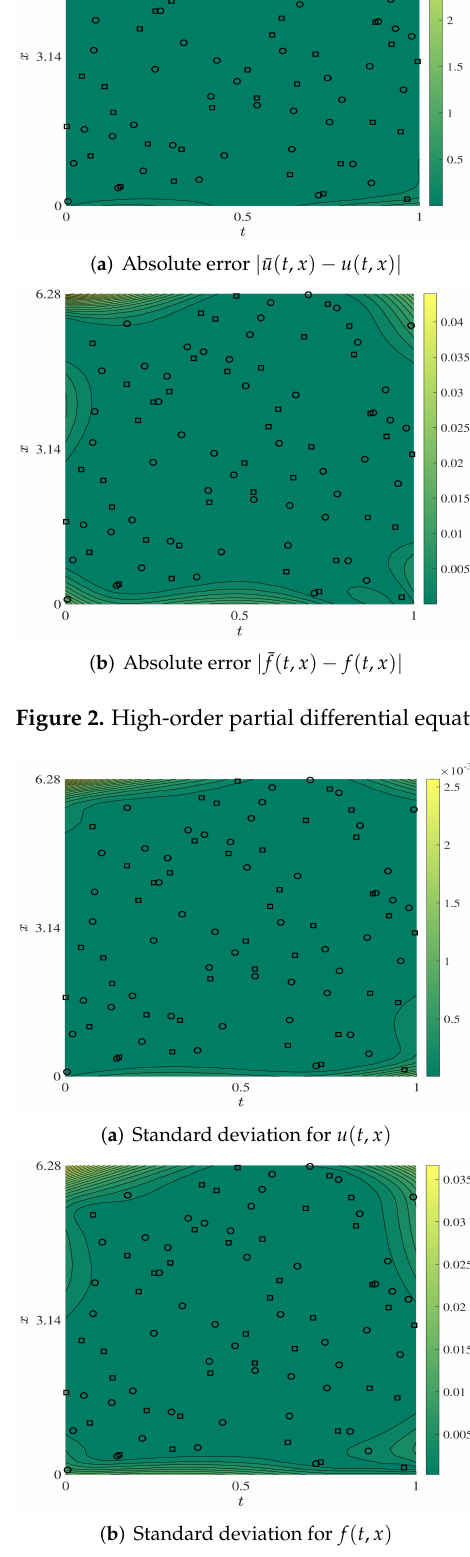
Figure 3. High-order partial differential equation: Standard deviation for u ( t , x ) and f ( t , x )